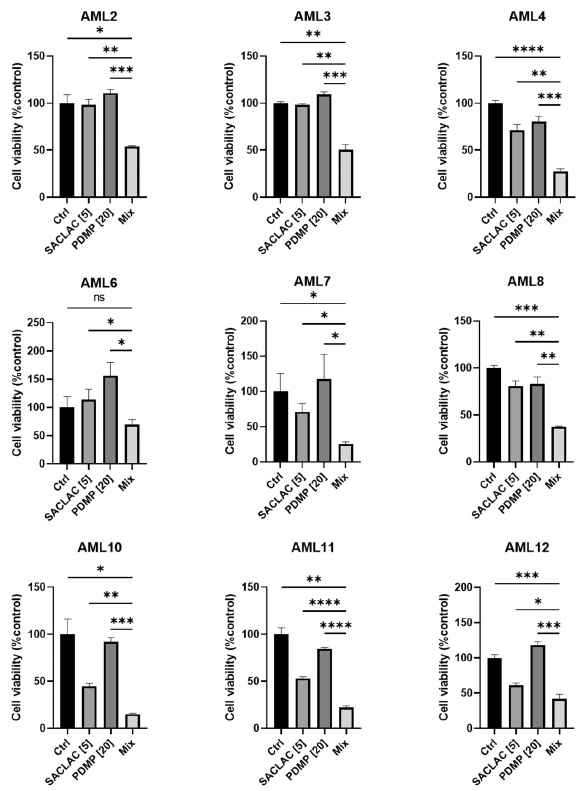
Figure 7. Combination SACLAC D- threo -PDMP treatment effectively reduces viability in primary de novo AML patient samples. Cell viability in a cohort of nine primary, previously untreated, de novo, AML patient PBMC samples treated with control (DMSO), SACLAC (5 µM), and/or PDMP (20 µM) for 48 h. Cell viability was measured using the CellTiter Glo luminescence assay. Luminescence was normalized to DMSO control treatment, which was set to 100%. Error bars represent the SD of three technical replicates. An unpaired t -test with Welch’s correction was used for statistical analysis (*, p < 0.05; **, p < 0.01; ***, p < 0.0005, ****, p < 0.0001). ns, not signi fi cant.